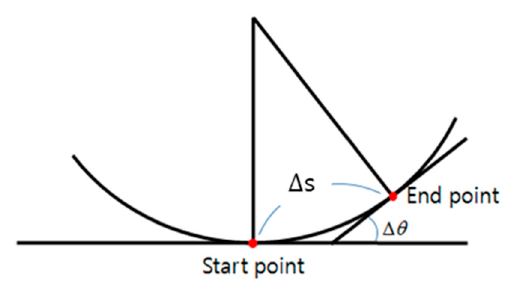
Figure 7. Curvature of the curve.